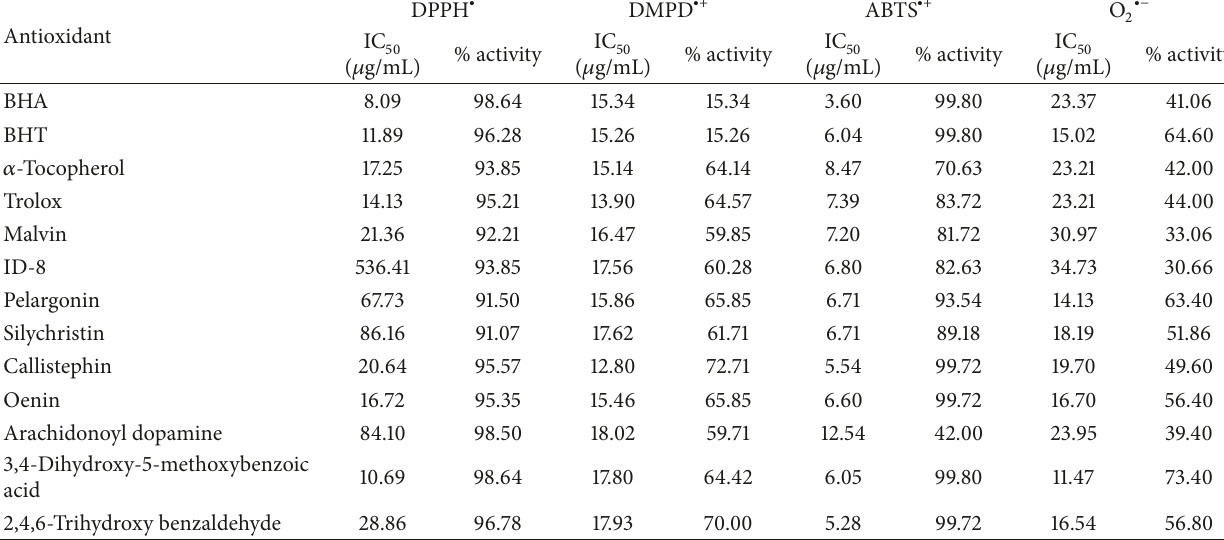
Table 2: Free radical scavenging activities (%) of reference antioxidants and selected phenolic and flavonoid compounds at 10 𝜇 g/mL concentration for ABTS and DMPD and at 20 𝜇 g/mL for O 2∙− and DPPH ∙ .